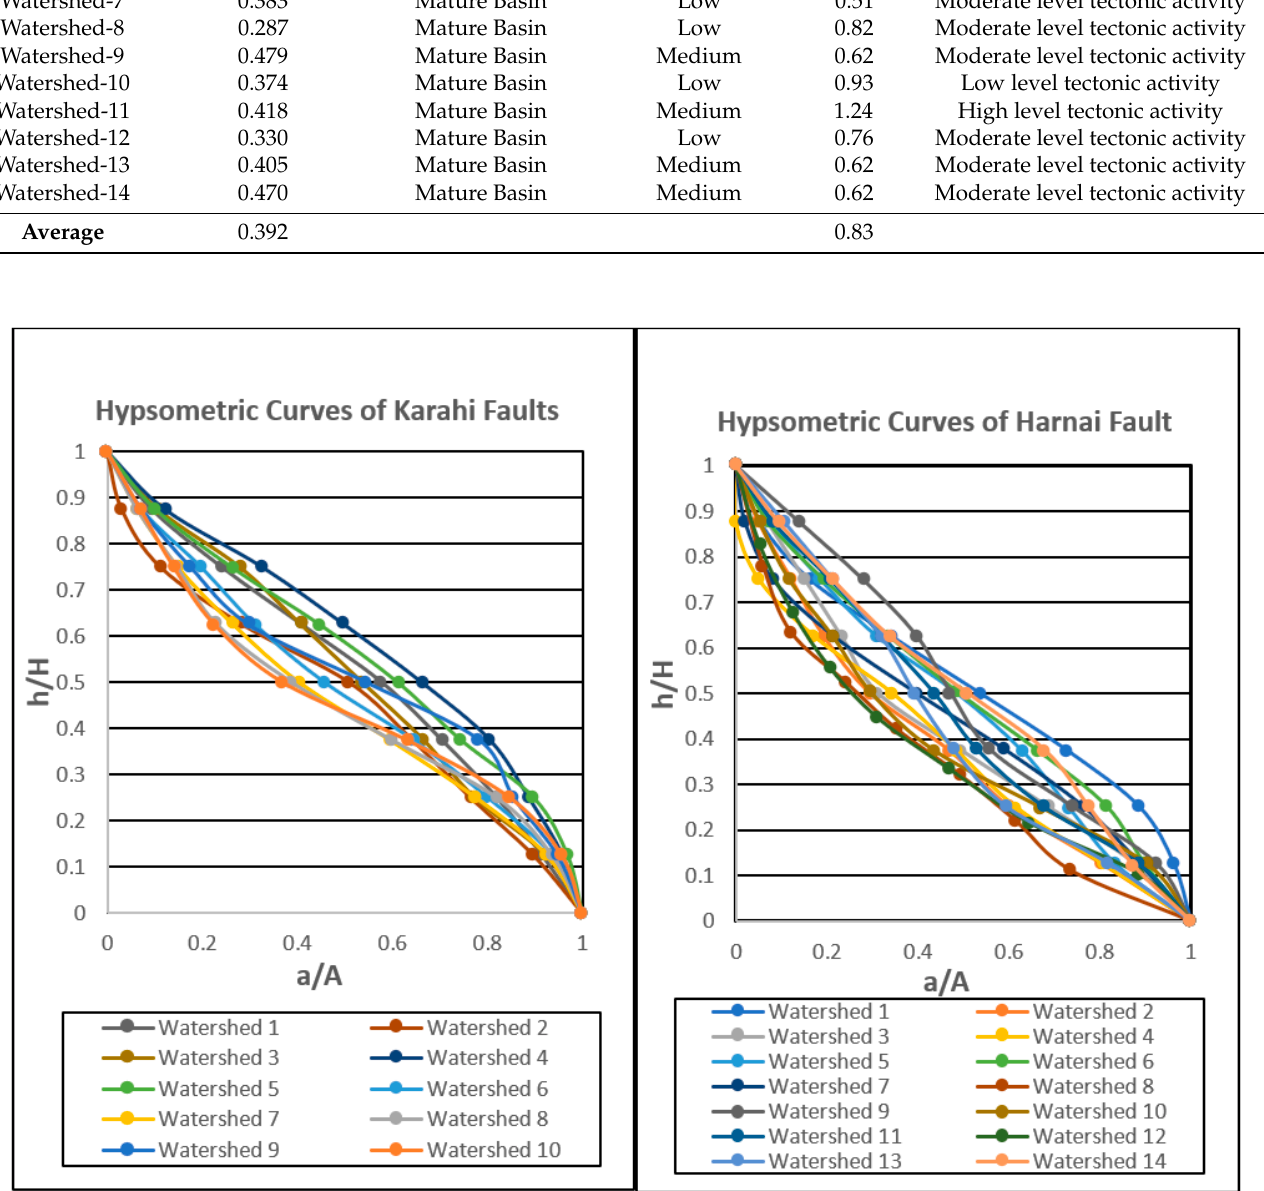
Figure 16. Hypsometric curves for Karahi and Harnai Faults.